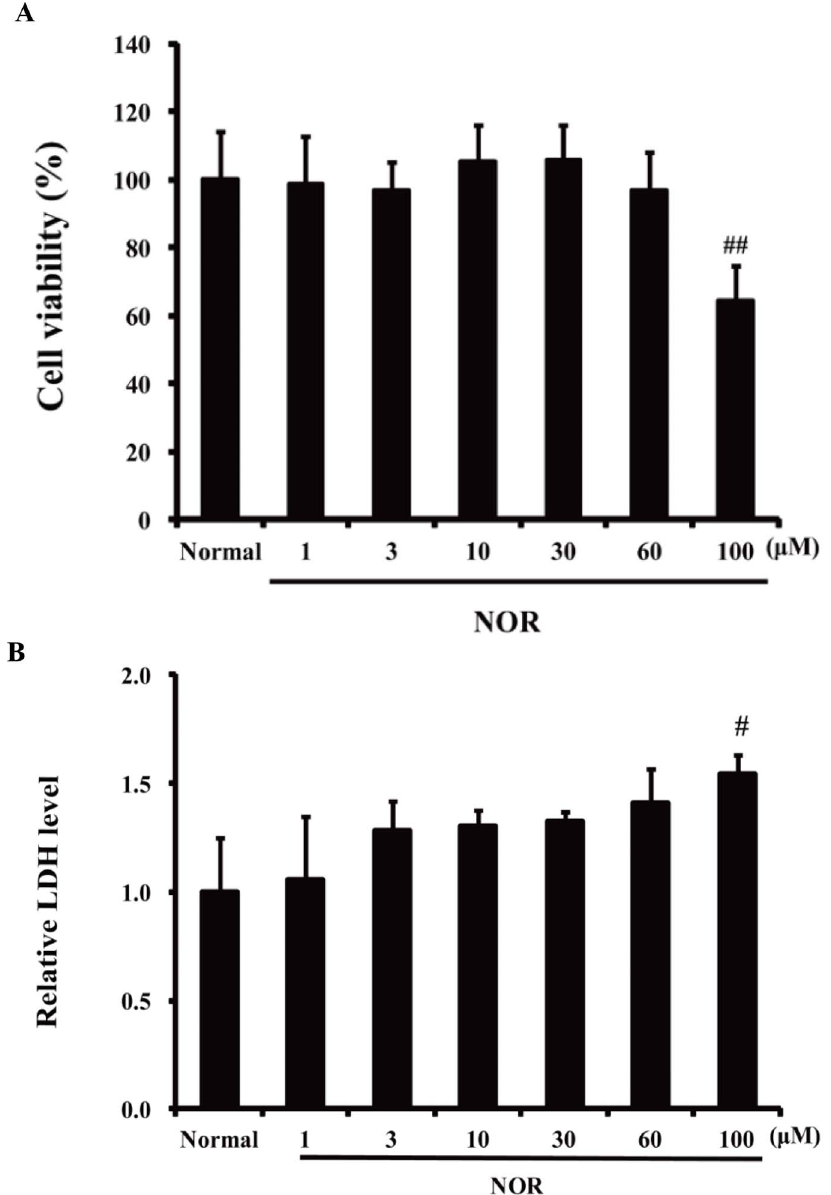
Figure 2. Cytotoxicity of norisoboldine (NOR) against HUVECs. ( A ) MTT assay. HUVECs seeded in 96-well plate were incubated with NOR (1, 3, 10, 30, 60, 100 m M) for 24 h. Then MTT assay was used to evaluate the viability. ( B ) LDH assay. HUVECs seeded in 96-well plate were incubated with NOR (1, 3, 10, 30, 60, 100 m M) for 24 h. Relative LDH release was used as an index of cytotoxicity. The data were expressed as mean 6 SD of three independent experiments. # P , 0.05, ## P , 0.01, vs . normal group.